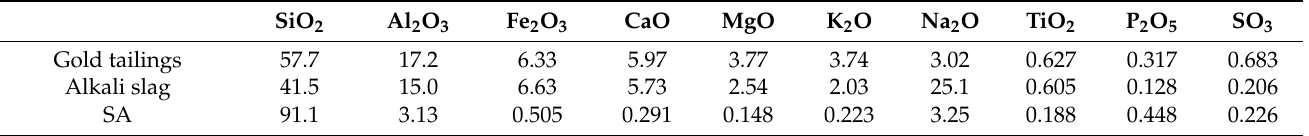
Table 3. Main components of the gold tailings, alkali slag, and SA (wt.%).